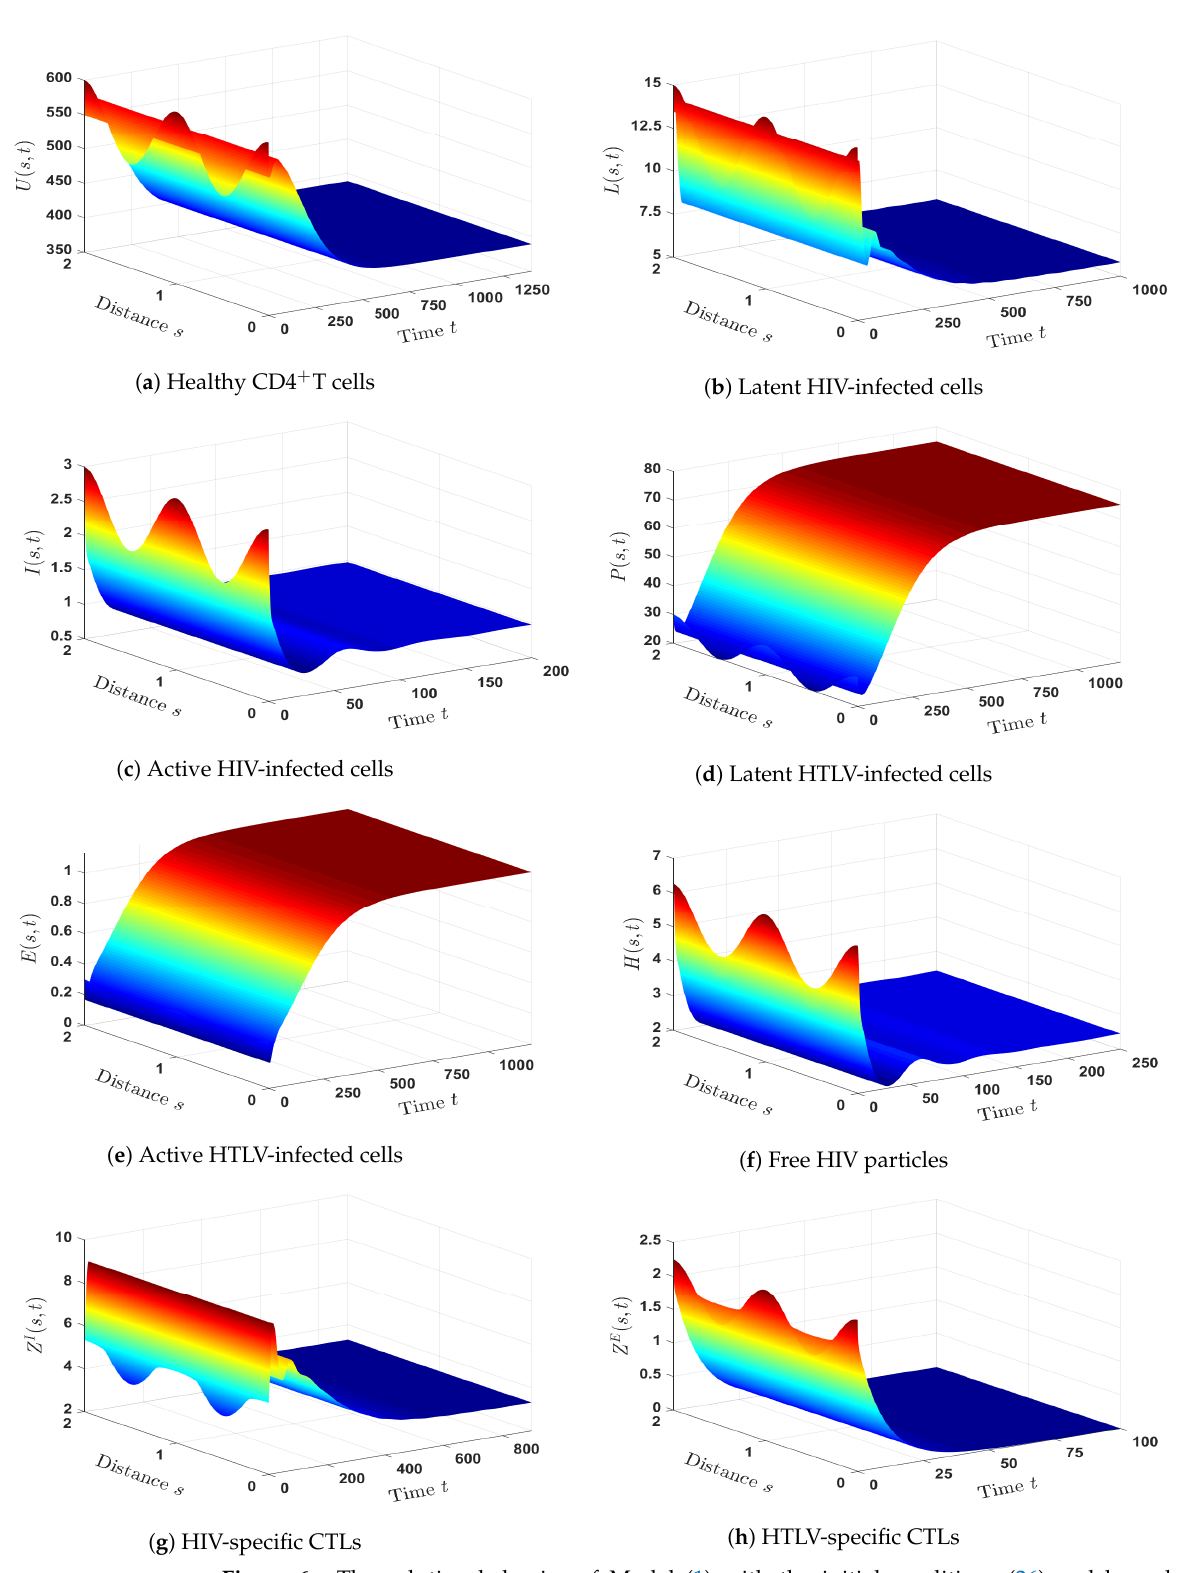
Figure 6. The solution behavior of Model (1) with the initial conditions (26) and boundary conditions (27). Taking ω 1 = 0.001, ω 2 = 0.0001, ω 3 = 0.0002, ω 4 = 0.011, υ 1 = 0.1, υ 2 = 0.01, we have ˆ R 5 = 5.64 > 1, R 5 = 1.93 > 1, R 8 = 0.21 < 1, R 1 / R 2 = 2.09 > 1, and the equilibrium ˇ S = ( 389.09,5.80,1,74.98,1.13,2.5,3.30,0 ) is asymptotically 5